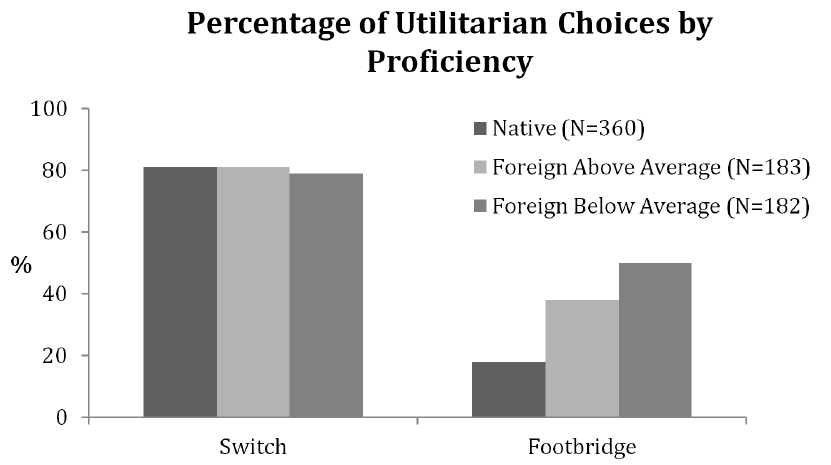
Figure 3. Percentage of utilitarian decisions by proficiency (Experiment 2). Percentage of utilitarian decisions for the two versions of the trolley problem in the native language condition and the foreign language condition, divided by self-rated proficiency level.